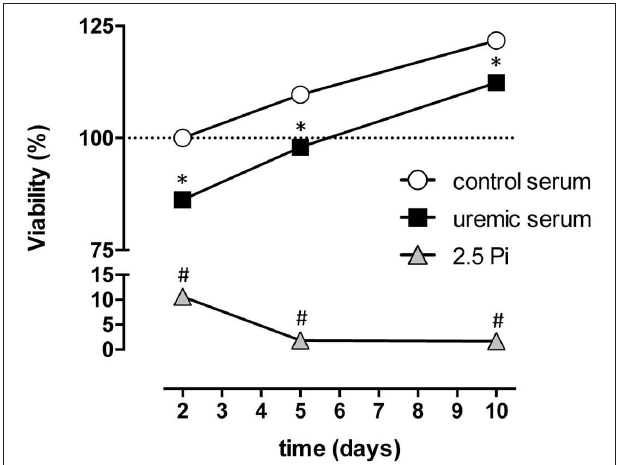
FIGURE 4 | Contrasting effects of high phosphate and uremic serum on HASMC viability. Cells were cultured either in DMEM supplemented with high phosphate (2,5 Pi) or 20% of control or uremic serum. Cell viability was assayed after 2, 5, and 10 days using the 2,3-Bis-(2-methoxy-4-nitro-5 -sulfophenyl)-2H-tetrazolium-5-carboxanilide salt (XTT) viability test. Values are expressed as the mean ± SE ( N = 3) and compared using a one-way